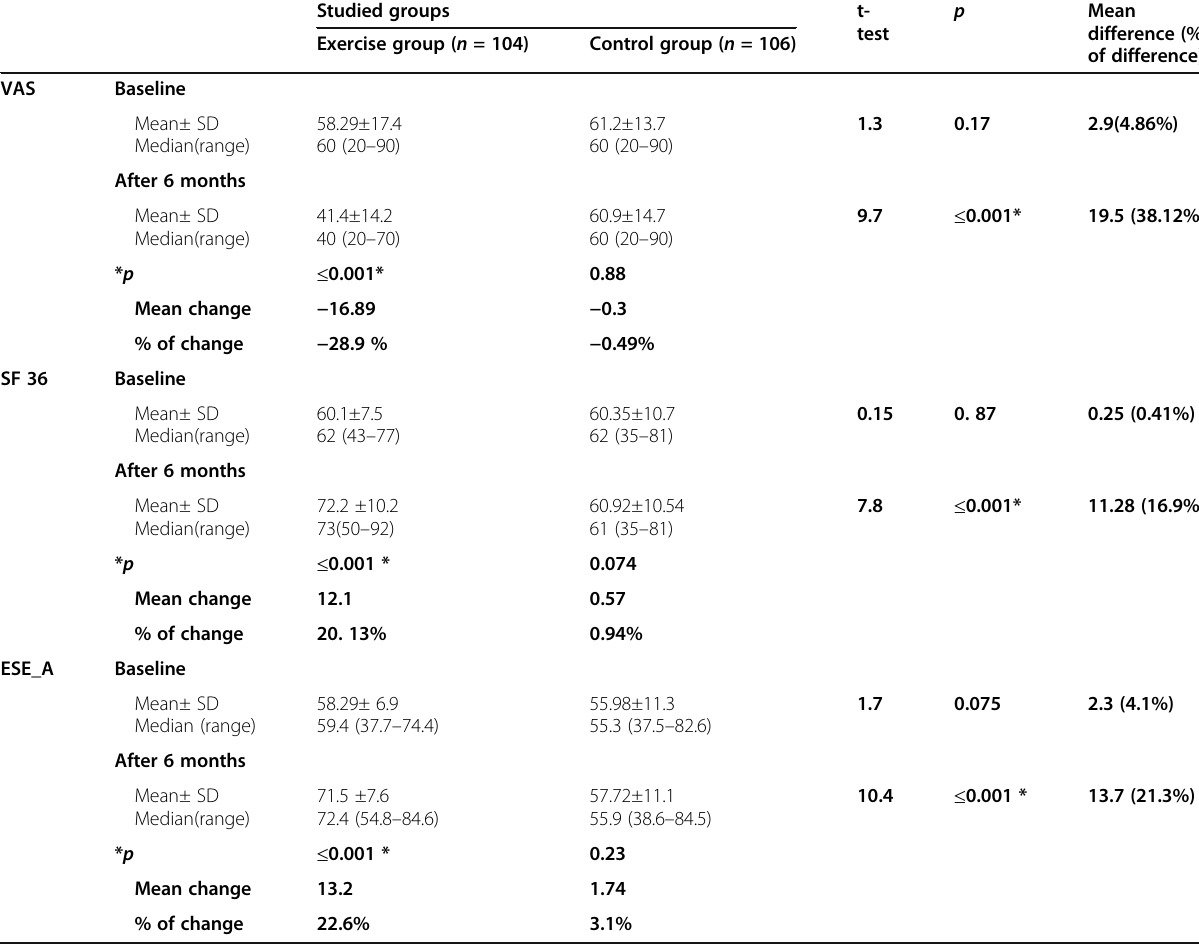
Table 2 Outcome measures of the exercise group and the control group at baseline and 6 months post-intervention Studied groups t-